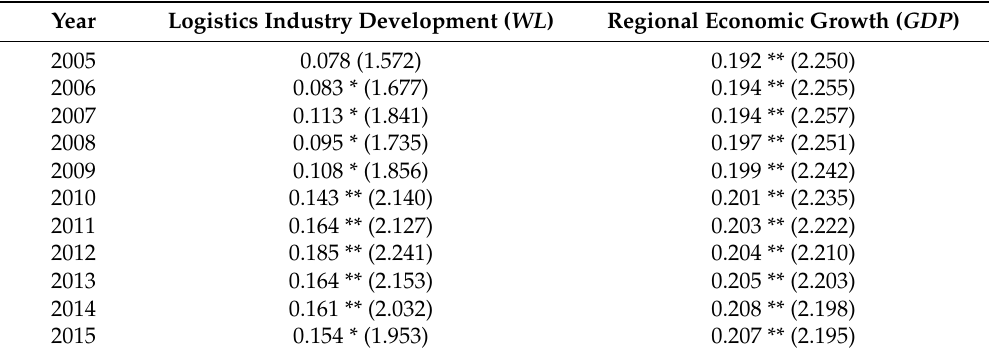
Table 3. The Moran’s Index of logistics industry development and regional economic growth.